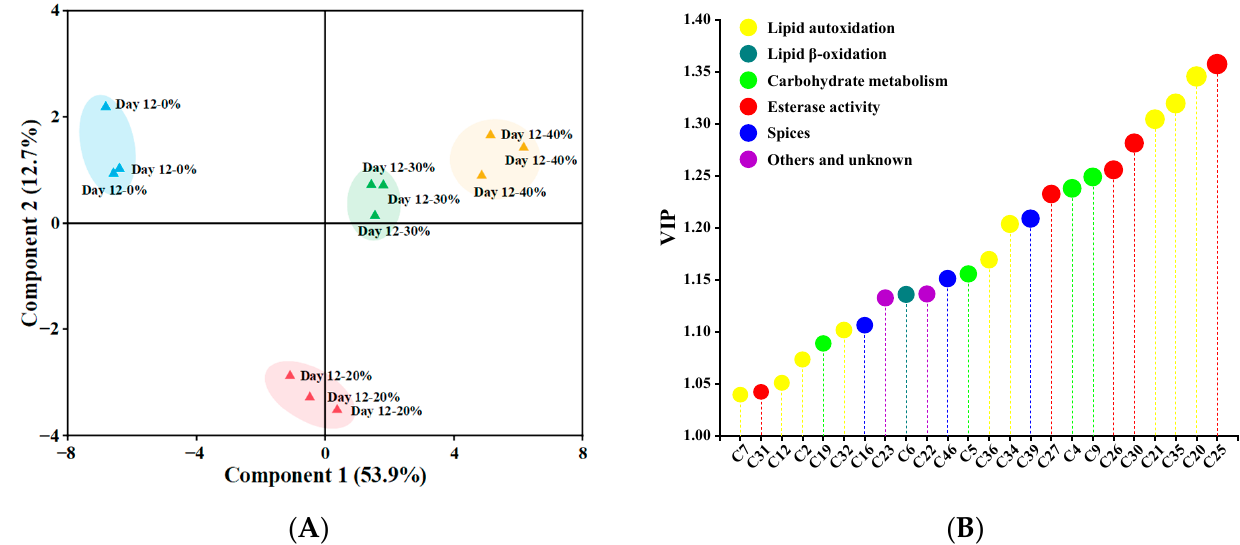
Figure 3. The partial least squares discriminant analysis score plots ( A ) and the variable importance in the projection (VIP) values ( B ) of significantly different ( p < 0.05) volatile compounds in traditional dry sausages with different KCl substitution ratios at day 12. The size of circle represents VIP value, the larger VIP value, the larger the circle. 0%: control dry sausage (2.50% NaCl); 20%: dry sausage with 20% KCl substituted for NaCl (2.00% NaCl + 0.50% KCl); 30%: dry sausage with 30% KCl substitution (1.75% NaCl + 0.75% KCl); 40%: dry sausage with 40% KCl substitution (1.50% NaCl + 1.00% KCl).